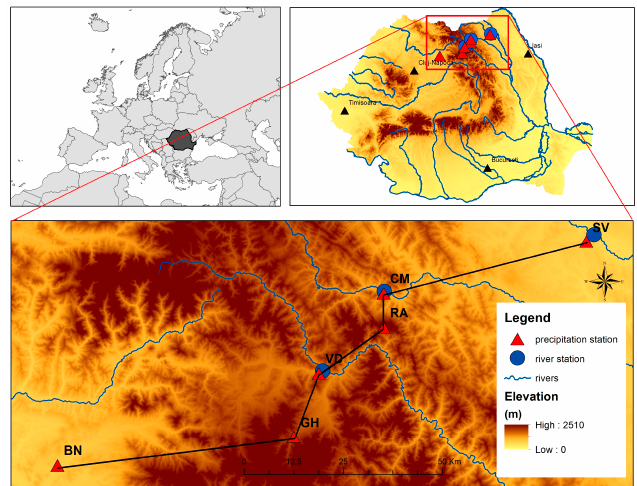
Figure 1. Site location in Europe ( top left ), in Romania ( top right ) and in the local context ( bottom ): Bistri ț a-N ă s ă ud (BN), Gura Haiti (GH), Vatra Dornei (VD), Rar ă u (RA), Câmpulung Moldovenesc (CM) and Suceava (SV). The black line represents the position of the elevation profile from Figure 2.